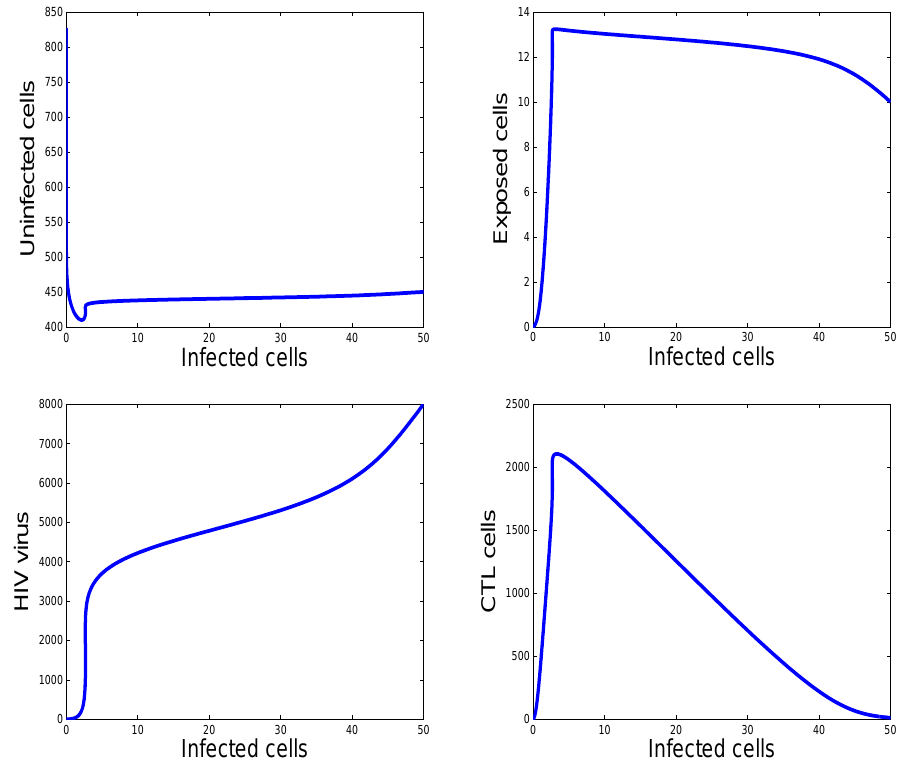
Figure 3. Selective phase portraits to illustrate the solution behavior of the infection dynamics when λ = 10, d 1 = 0.0139, k 1 = 0.04, d 2 = 0.0495, k 2 = 1.1, d 3 = 0.5776, a = 2, d 4 = 0.6, p = 0.0024, c = 0.15, b = 0.5.